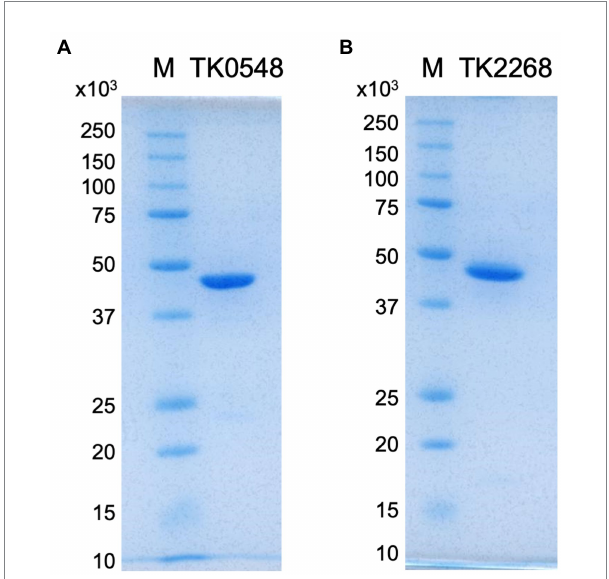
FIGURE 2 SDS-PAGE analyses of the purified TK0548 (A) and TK2268 (B) recombinant proteins. Two micrograms of purified TK0548 and TK2268 recombinant proteins were applied to each gel. Gels were stained with Coomassie Brilliant Blue. M indicates molecular weight